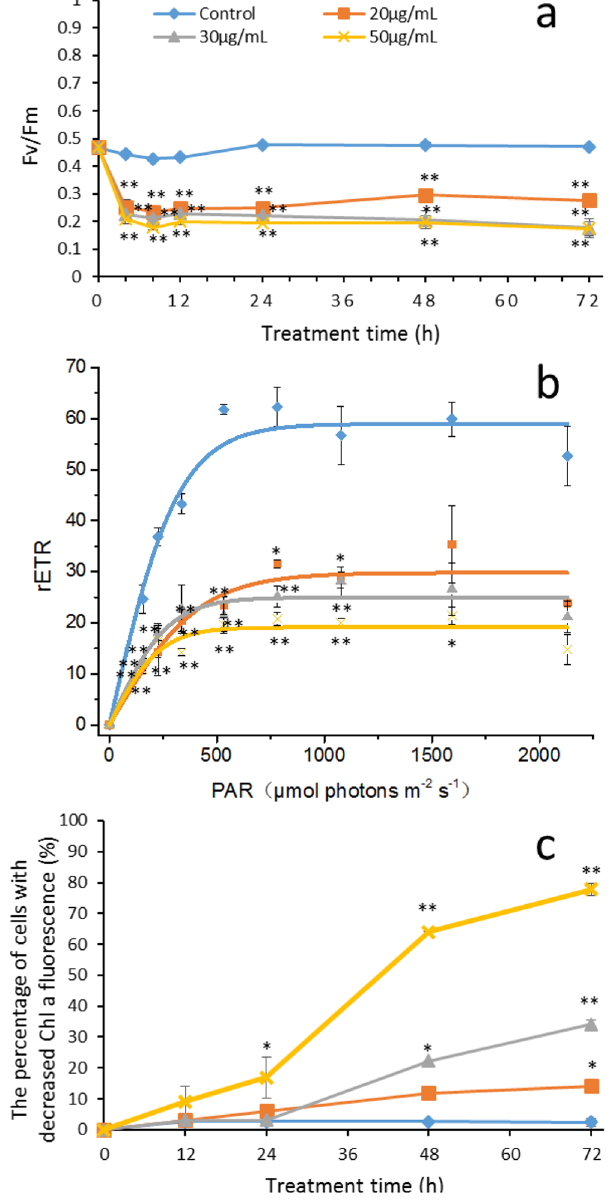
Figure 8. Effect of PG on ( a ) Fv/Fm, ( b ) rETR (4 h), and ( c ) Chl a fluorescence of M. aeruginosa . Values are means ± SD (n = 3). * ( p < 0.05) and ** ( p < 0.01) represent significant differences compared to the control